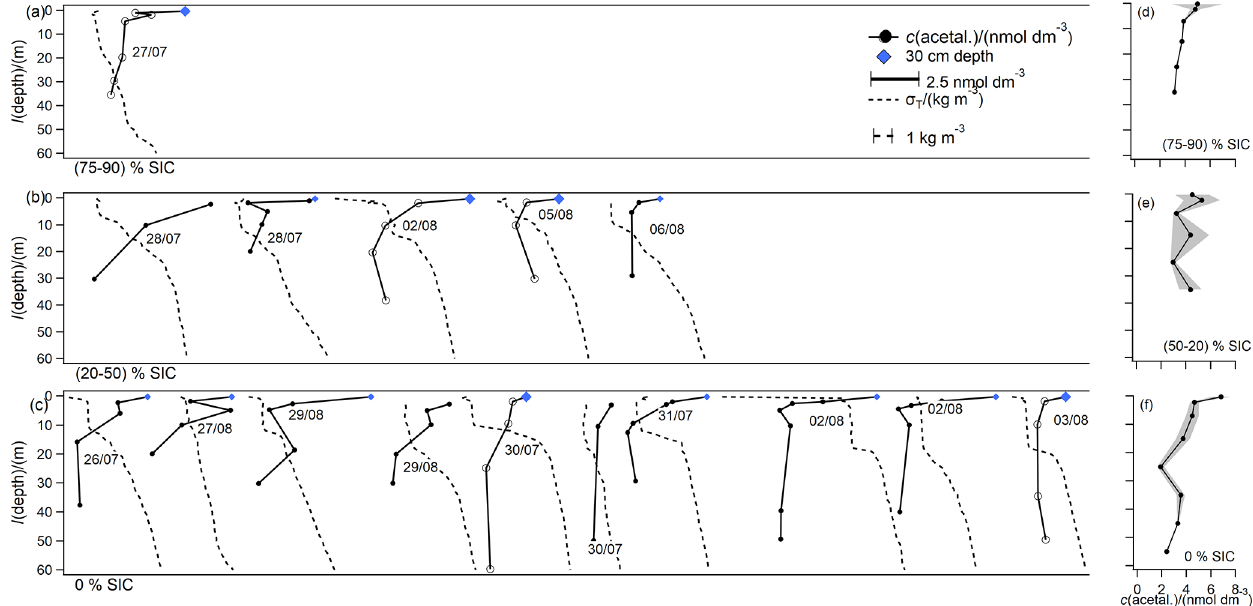
Figure 4. Overview plot displaying the shape of all acetaldehyde and density ( σ T ) depth profiles, grouped by SIC and staggered along the x axis for ease of viewing. Panel labels indicate the SIC bin. The scale bars for acetaldehyde and density in (a) also apply to (b) and (c) . Profiles with hollow markers are highlighted in Fig. 7. Sampling dates are indicated to locate stations using Fig. 1. Panels (d) to (f) indicate absolute concentrations of mean vertical profiles grouped according to ice cover and binned by depth horizons. The shaded area indicates standard error for each depth horizon (acetal. is short for